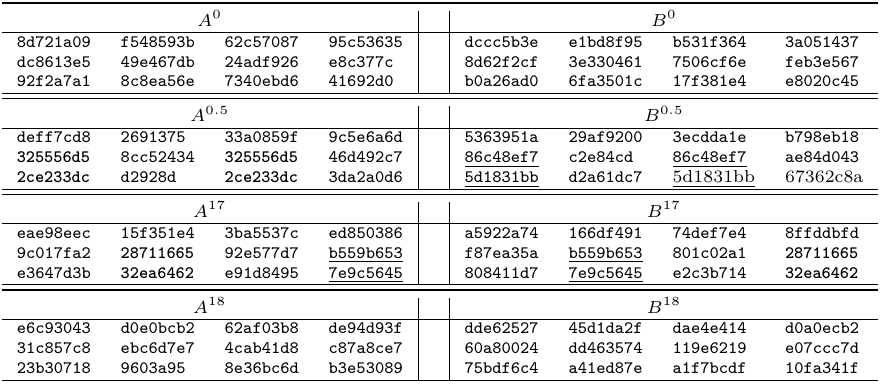
Table 2: An example of the desired tuple ( A 0 , A 18 , B 0 , B 18